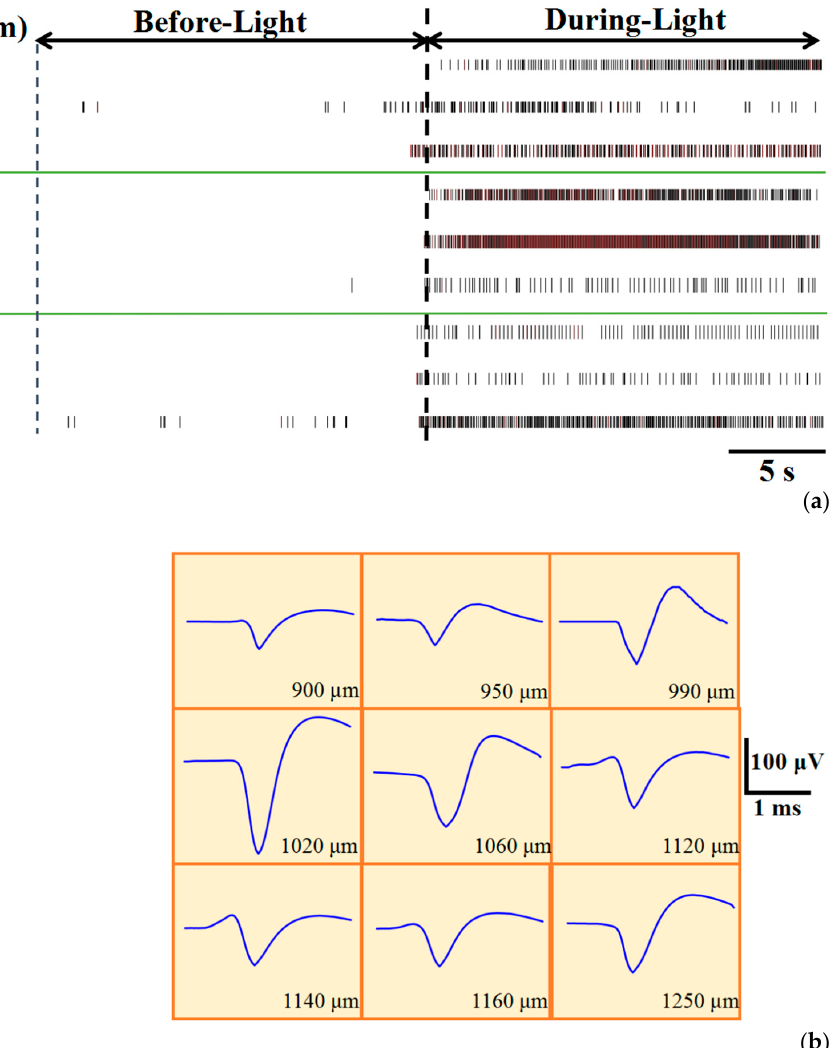
Figure 3. ( a ) The real-time recordings of spikes before and during blue light illumination at different depths (here we only selected one channel for each group of experiments as a display); ( b ) the spike waveform of neurons at different